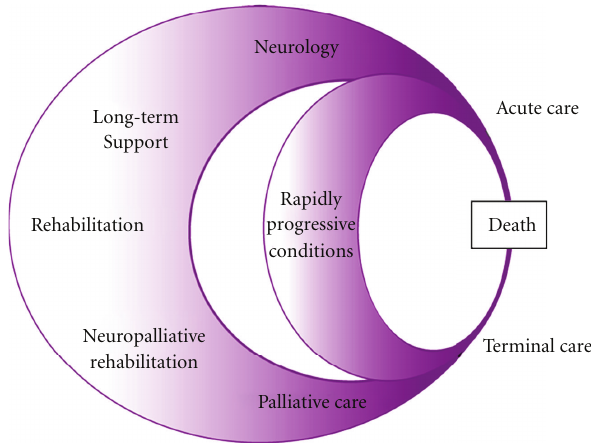
Figure 2: Life overlap diagram: interface between neurology, rehabilitation and palliative care in the management of persons with long-term neurological conditions and primary progressive multiple sclerosis. (Printed with permission: Turner-Stokes et al.